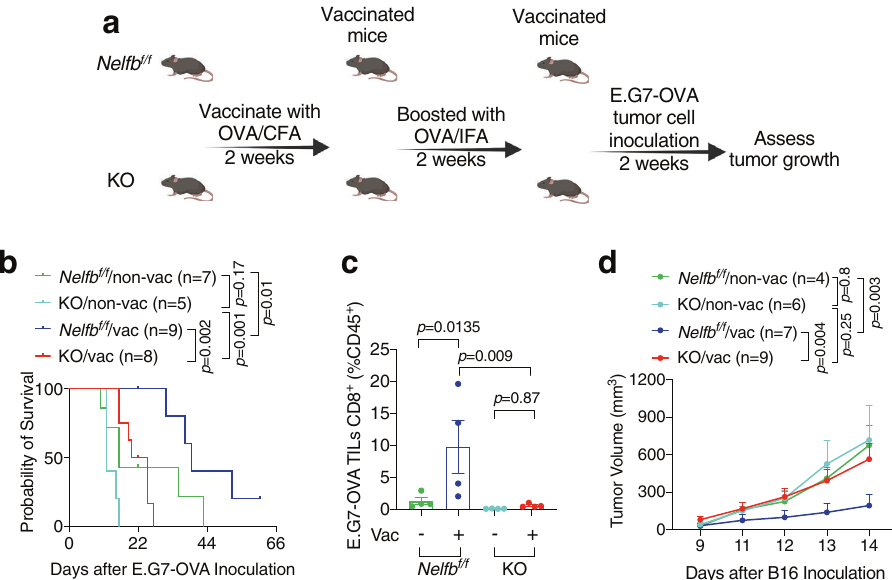
Fig. 2 Nelfb deletion in T cells impairs memory response to tumor antigen vaccination. a Scheme of vaccination procedure using OVA protein followed by E.G7-OVA tumor challenge. b Survival curve for E.G7-OVA tumor-bearing Nelfb f/f and KO mice with or without vaccination. c CD8 + percentages among E.G7-OVA tumor-in fi ltrating CD45 + cells; n = 4/group. d B16 tumor growth curve in Nelfb f/f and KO mice with or without vaccination; Nelfb f/f non-vac ( n = 4), Nelfb f/f vac ( n = 7), KO non-vac ( n = 6), KO vac ( n = 9); one-way-ANOVA for comparing mean differences. Tumor curves were compared using two-way ANOVA followed by multiple comparisons. Source data are provided as a Source Data fi